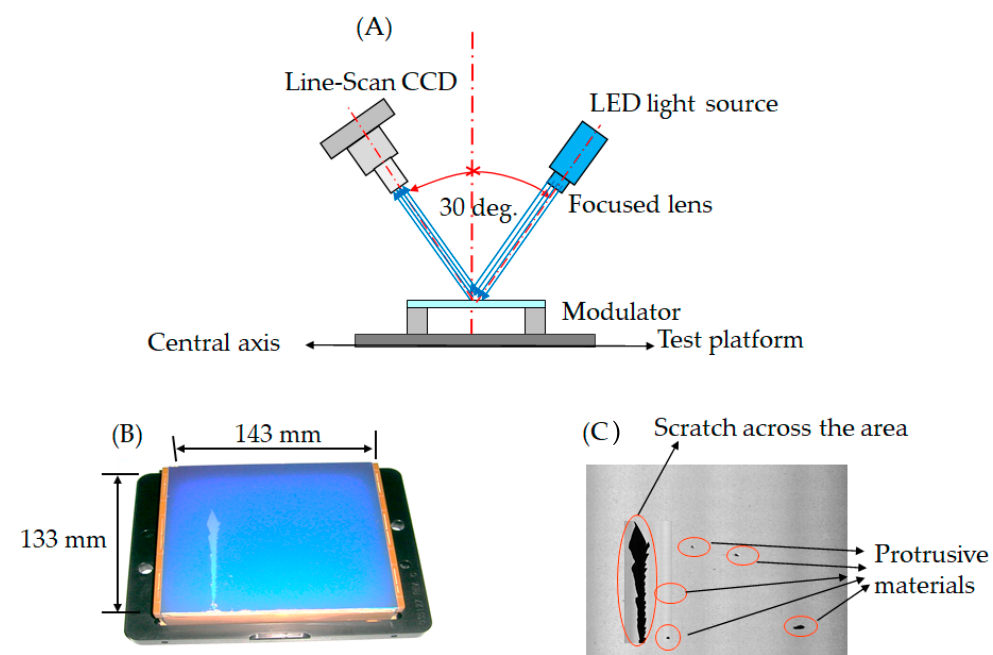
Figure 5. Topology of protrusion defects on the modulator: ( A ) architecture of machine vision; ( B ) a damaged modulator with the size 143 mm × 133 mm; and ( C ) gray image with visual defects .